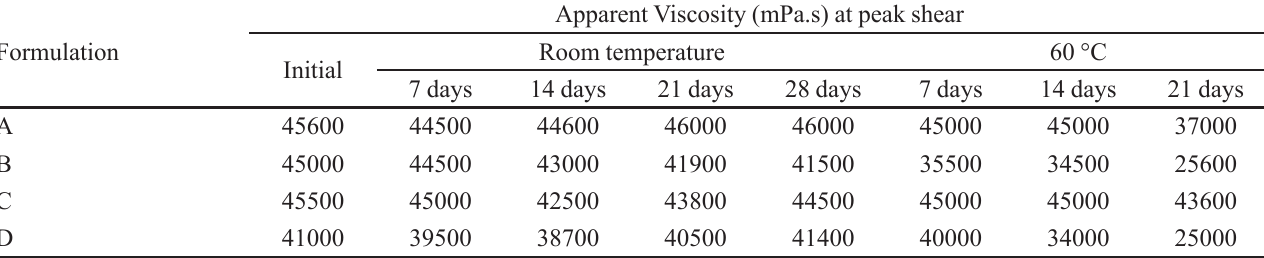
A: vehicle; B: vehicle plus propolis extract; C: vehicle plus tocopheryl acetate; D: vehicle plus propolis extract and tocopheryl